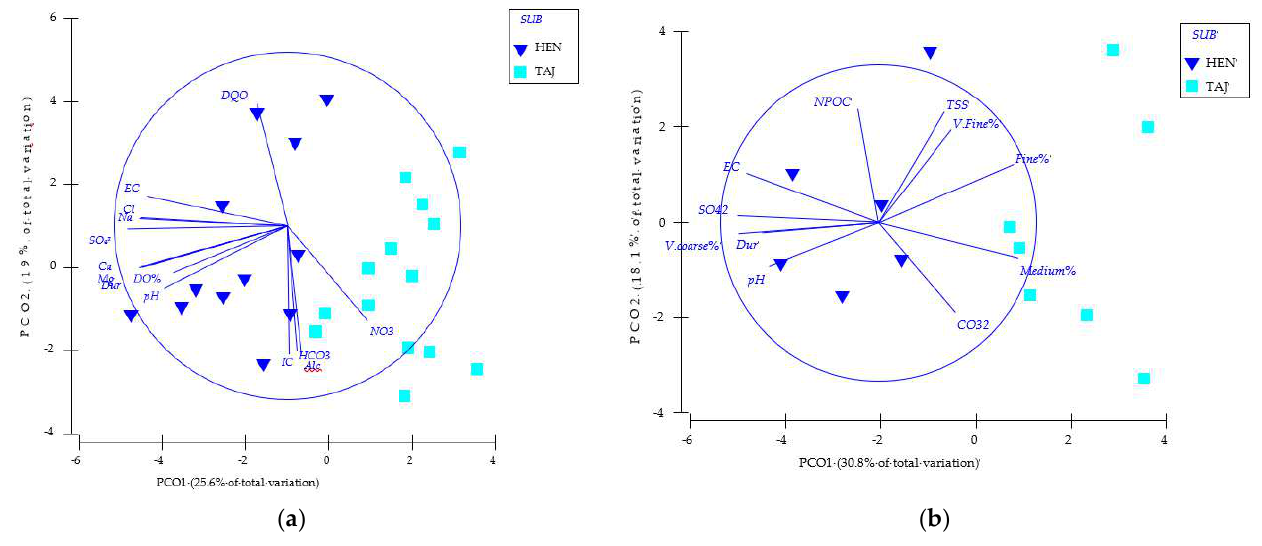
Figure 4. Principal coordinate analysis (PCO) plot of samples from the investigated sub-basin: Site 1 (a) (HEN—Heras de Ayuso, Henares River) and Site 2 (b) (TAJ—Romanones, Tajuna River) based on environmental parameters (abbreviations as in Table 1).